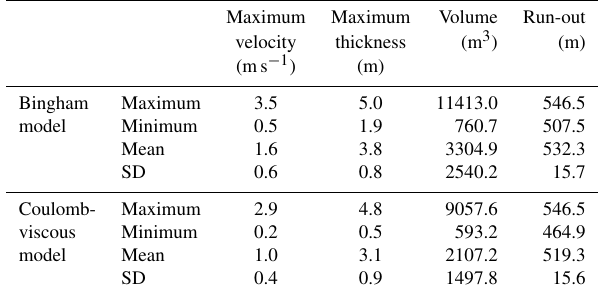
Table 2. Statistical summary for the 180 simulations performed with Bingham and Coulomb-viscous models for DF#1.